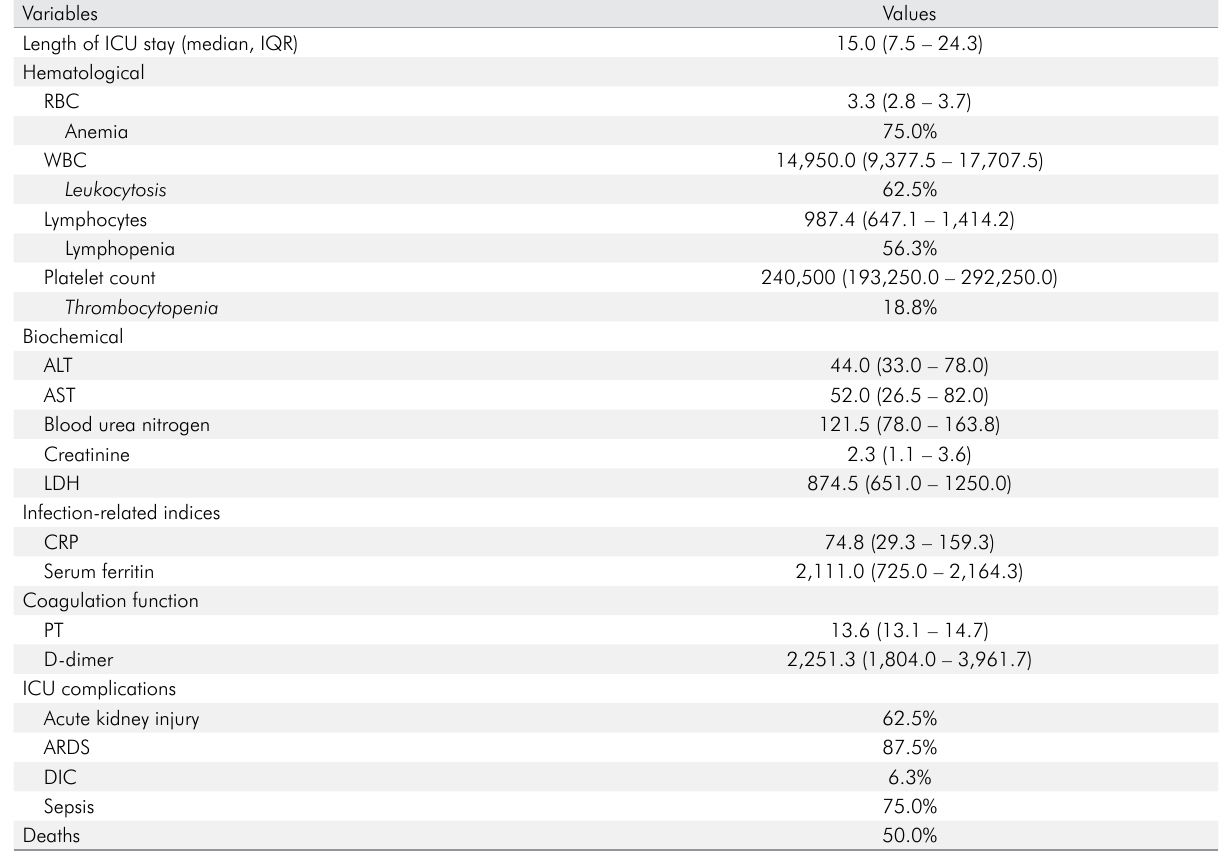
Table 2. Length of ICU stay, laboratory findings, and complications of patients with COVID-19 included in this case series. Variables